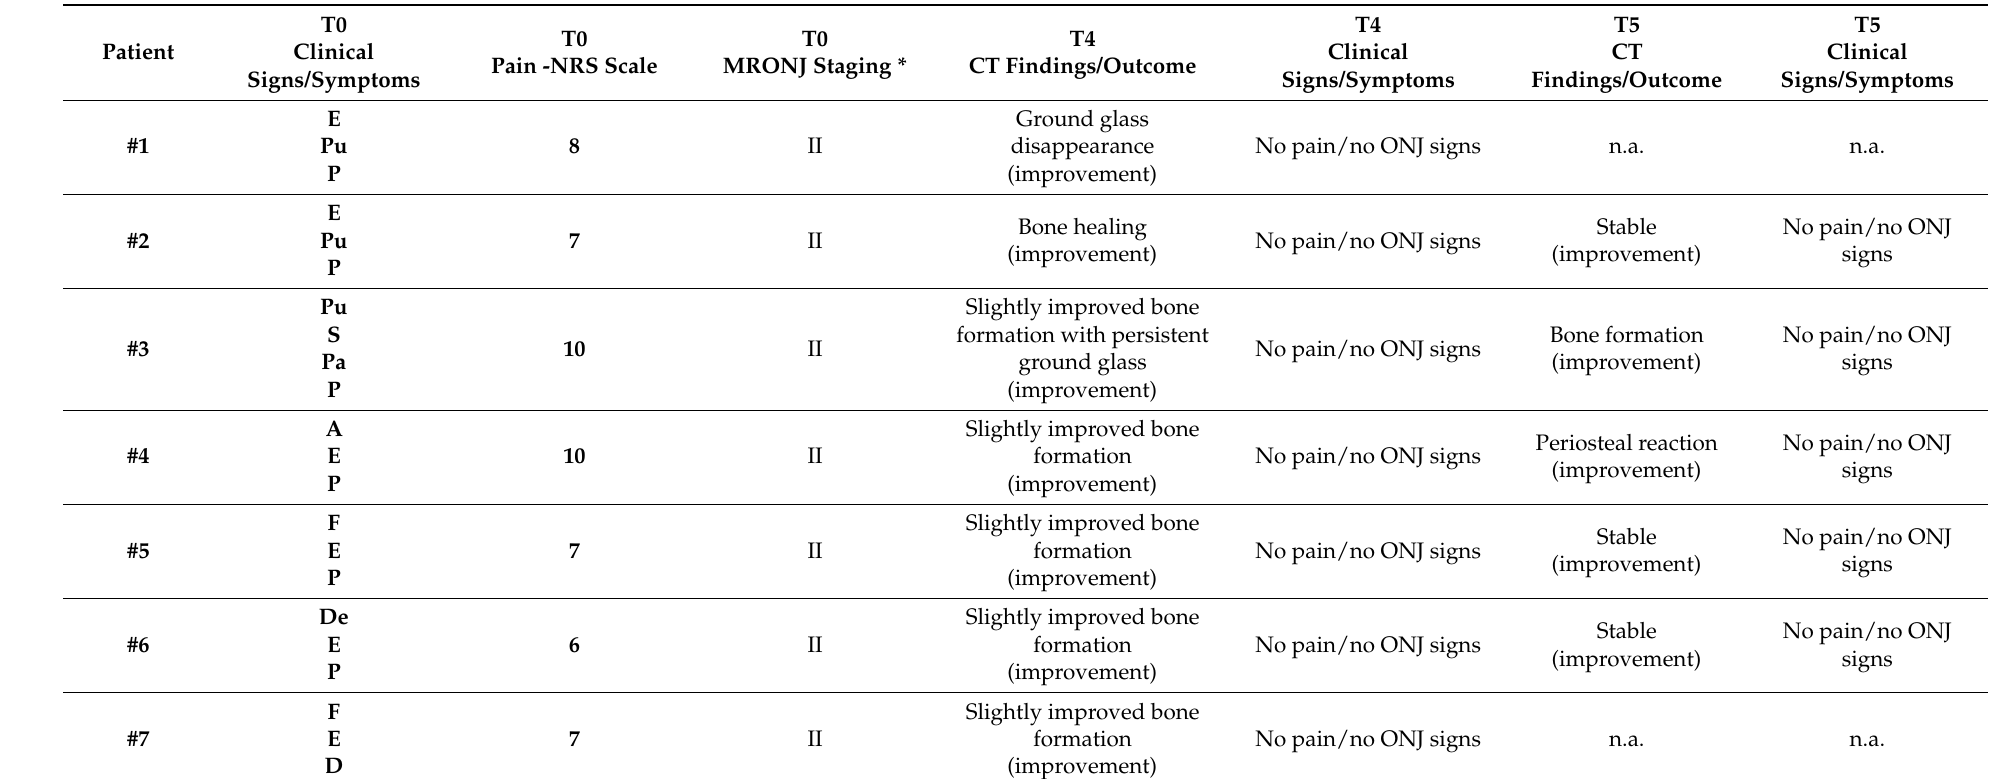
Table 4. Details of CT/CBCT